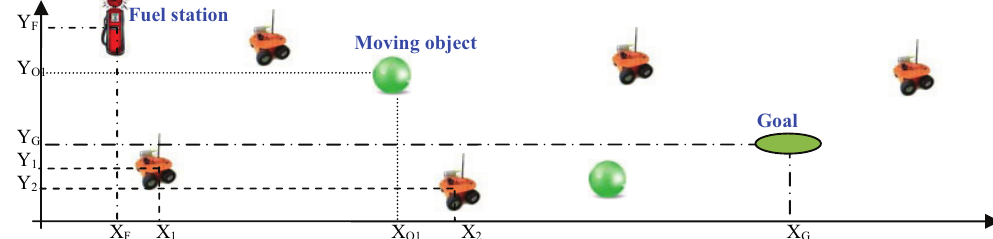
Fig. 3. Environment of multi-robot foraging problem